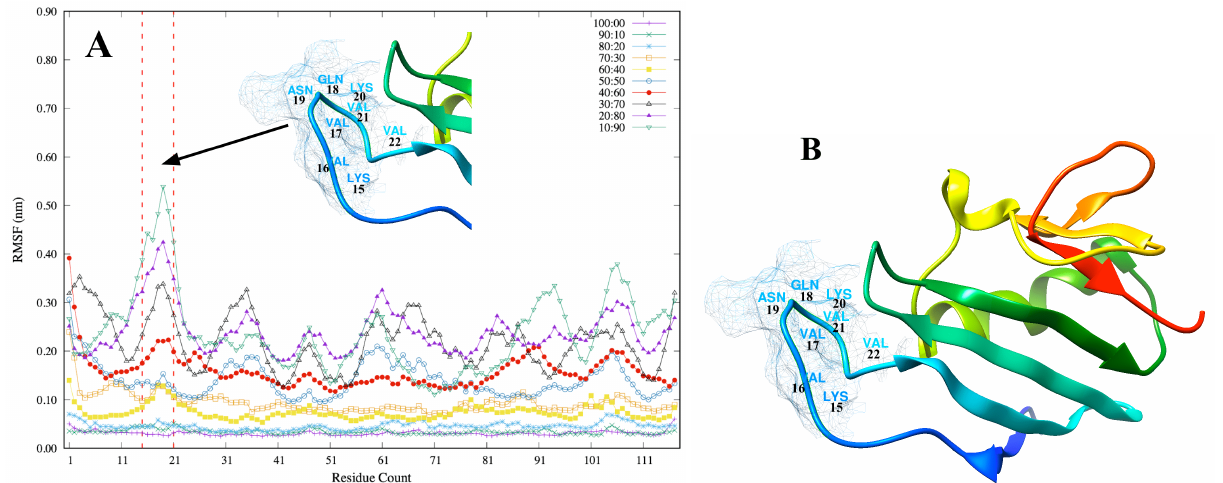
Figure 4. Individual residue flexibility in the RVFV protein domain measured as the RMSF . ( A ) calculated protein RMSF values from all the solvent concentrations; ( B ) a snapshot of the entire domain with a mesh and residue name labels for the highly flexible